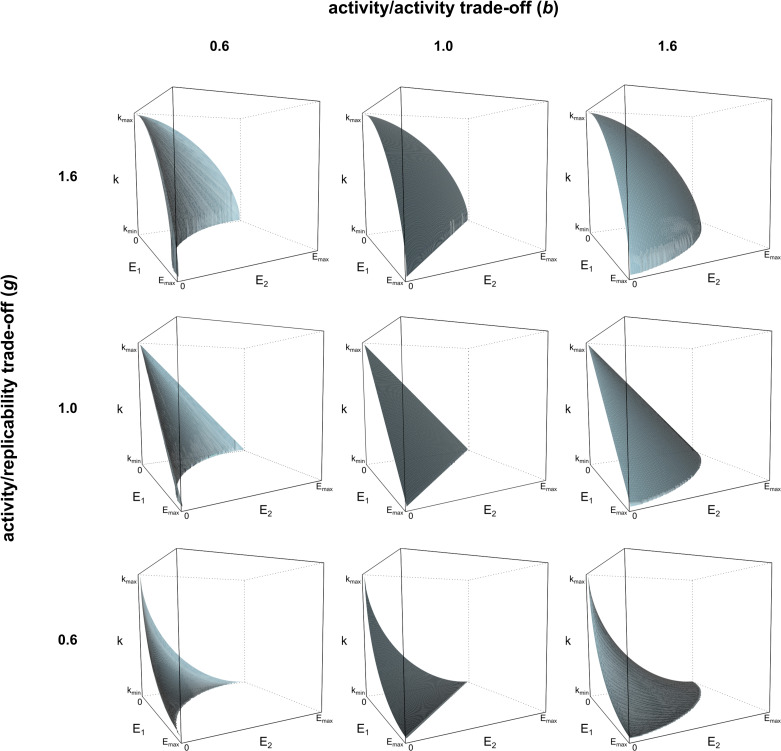
Trade-off surfaces with two enzyme activities.The surfaces delimit the section of the trait space that replicators can occupy in case of A = 2. The surfaces are calculated by Eqs 6 and 7; all replicators take trait values from below the trade-off surfaces shown. The axes are the two enzymatic activities (E1 and E2) and replicability (k). Catalytic (activity/activity) trade-off differs in columns (left: strong, middle: neutral, right: weak) and activity/replicability trade-off differs in rows similarly (bottom: strong, middle: neutral, top: weak).